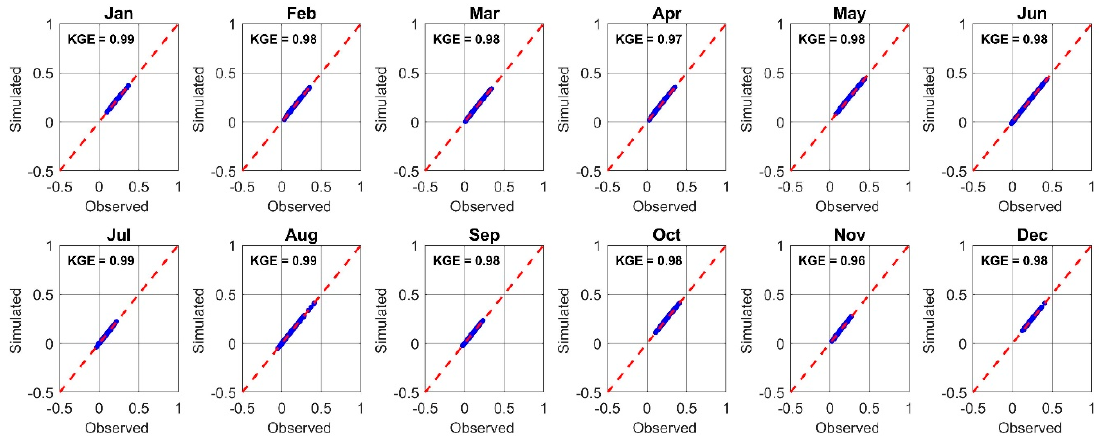
Figure 5. Comparison of the daily precipitation state correlation between the observations and simulations for each month for all grid-cells.